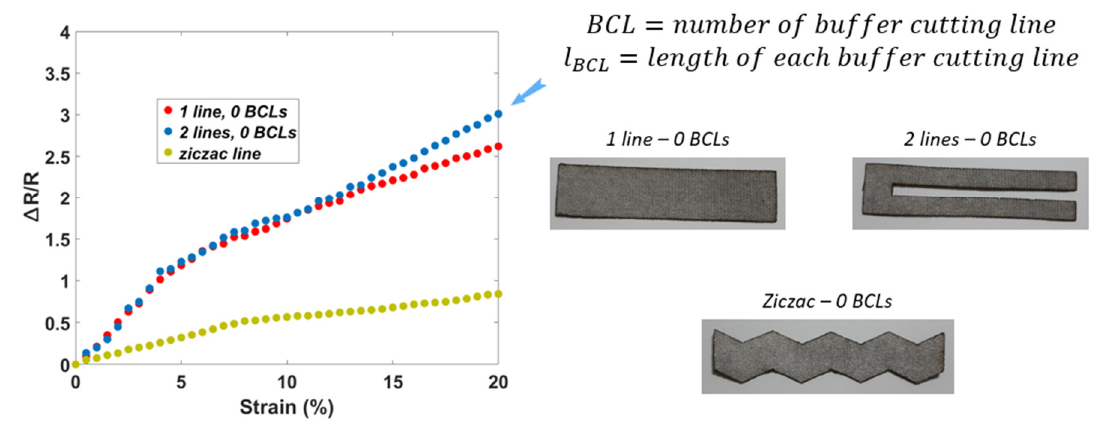
Figure 4. The first round in optimizing sensor performances based on different shapes.